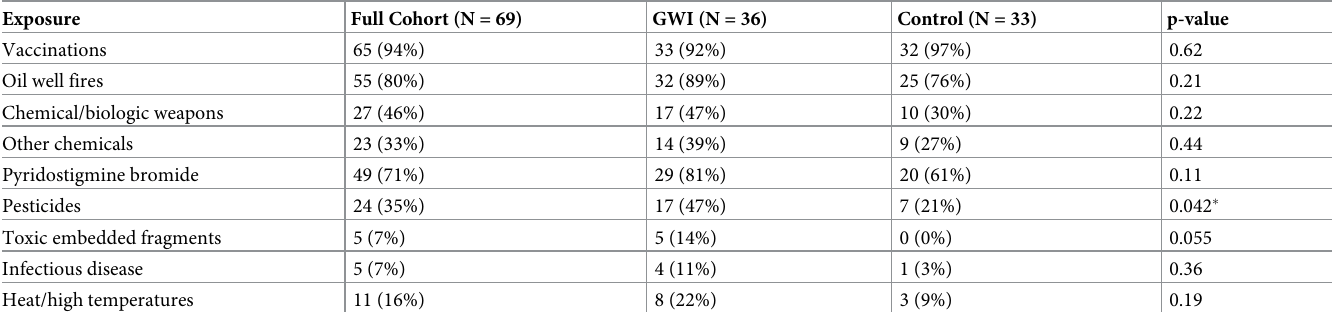
Table 4. Reported exposures by group.